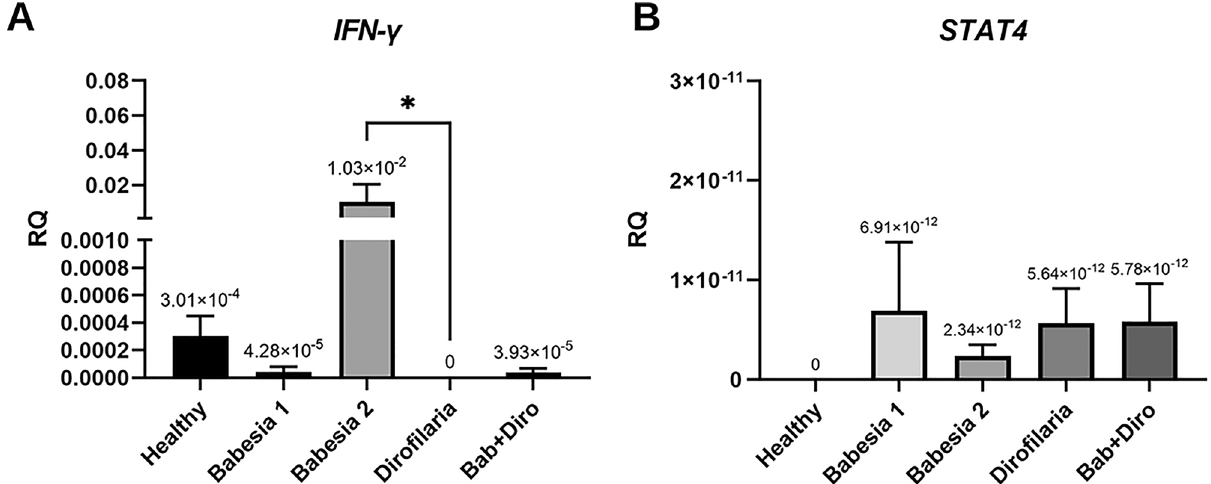
Figure 1. Relative expression of genes associated with Th1 response. Expression of ( A ) INF-γ and ( B ) signal transducer and activator of transcription STAT4 in healthy dogs, dogs infected with B. canis, D. repens and co-infected with B. canis and D. repens (Bab +